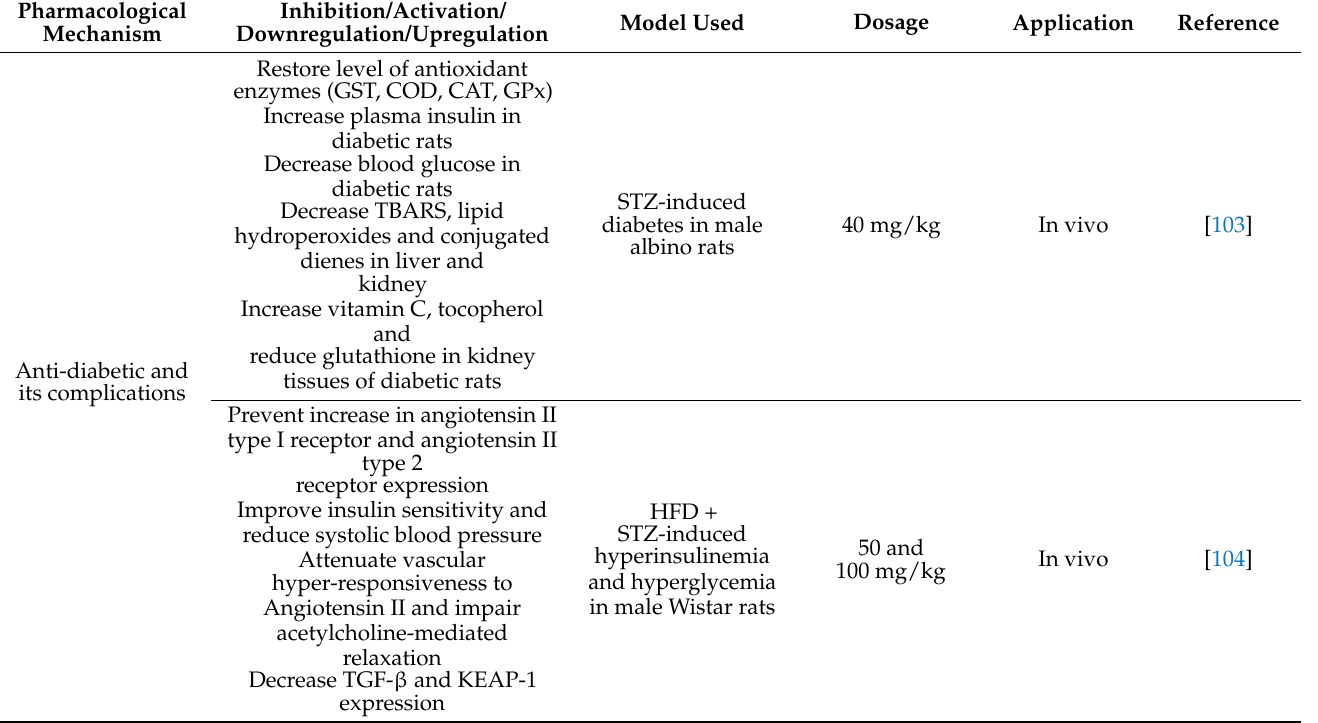
Table 5. Mechanism and function of esculetin in treatment of diabetes and